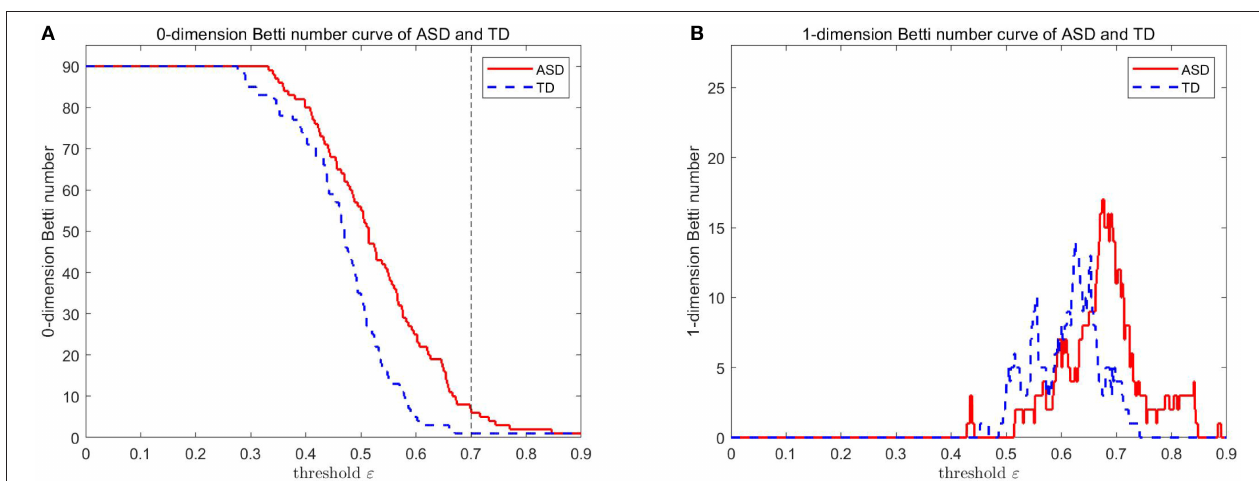
FIGURE 3 | 0-D and 1-D Betti number curves of the ASD brain network and the TD brain network.